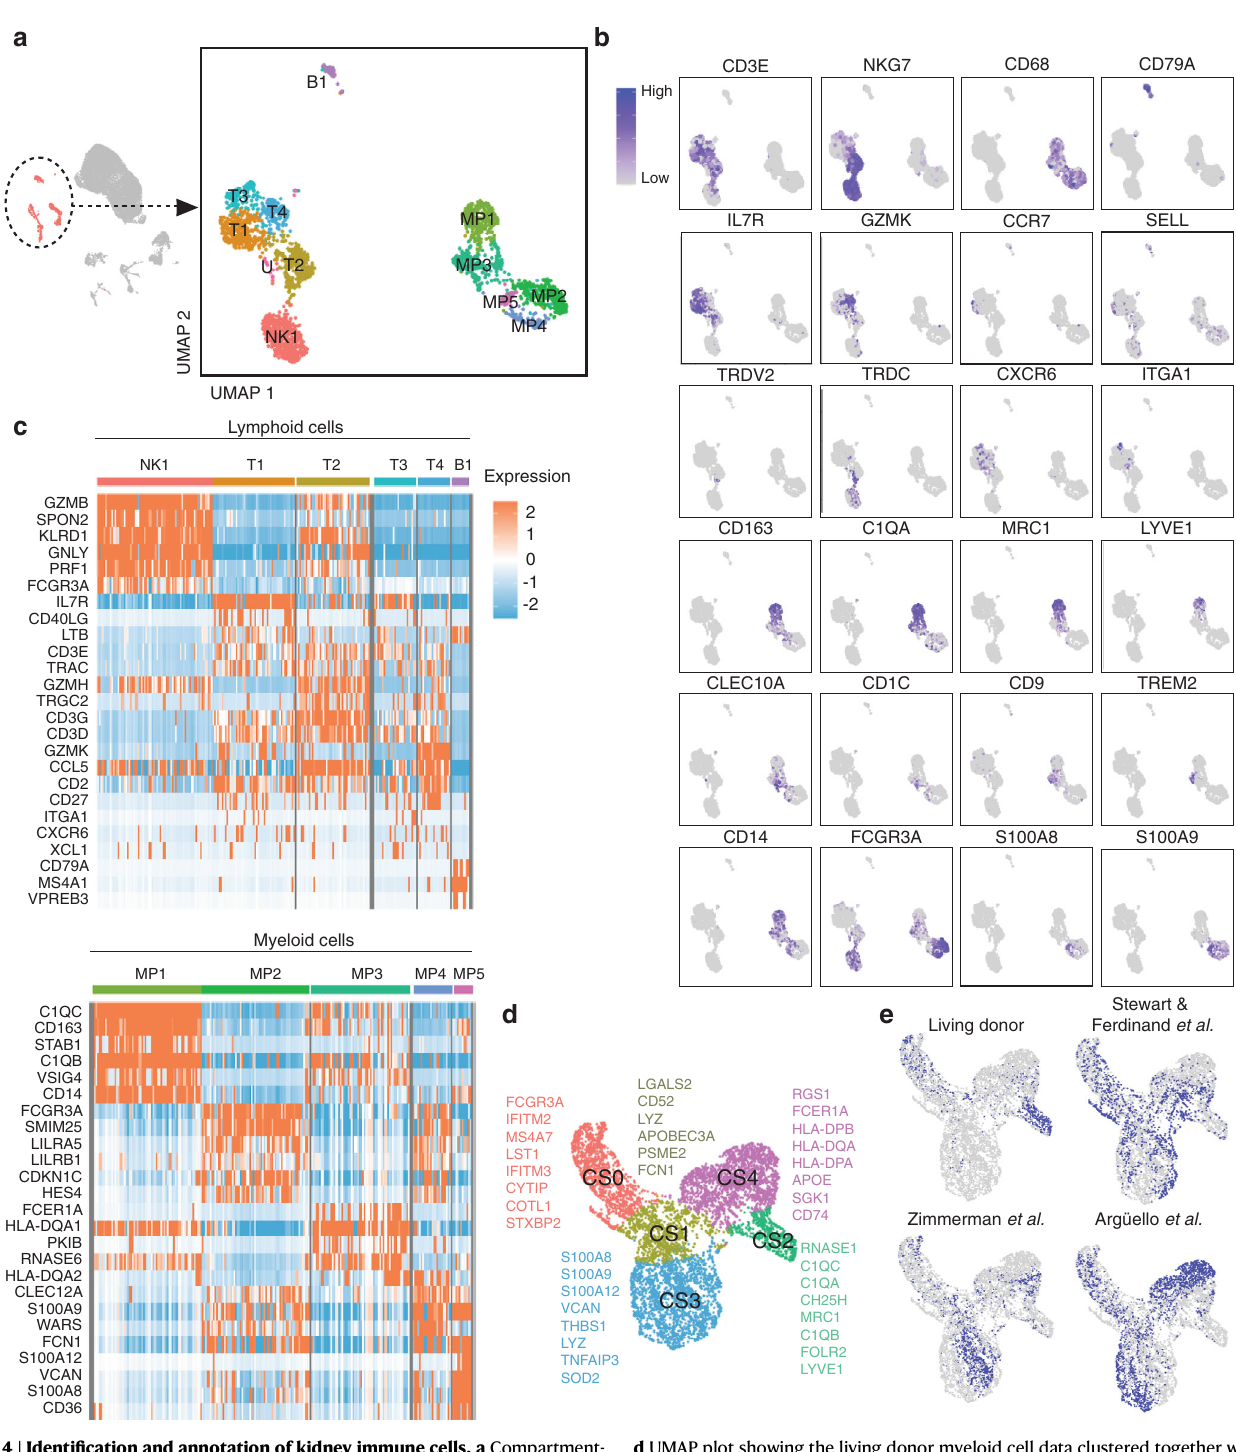
Fig. 4 | Identi fi cation and annotation of kidney immune cells. a Compartment- speci fi c analysis of 2491 immune cells comprising 12 clusters and b cell type mar- kers used for cluster annotations. c Heatmap of cell-type de fi ning and highly expressed genes by each cluster separated by lymphoid and myeloid lineage.